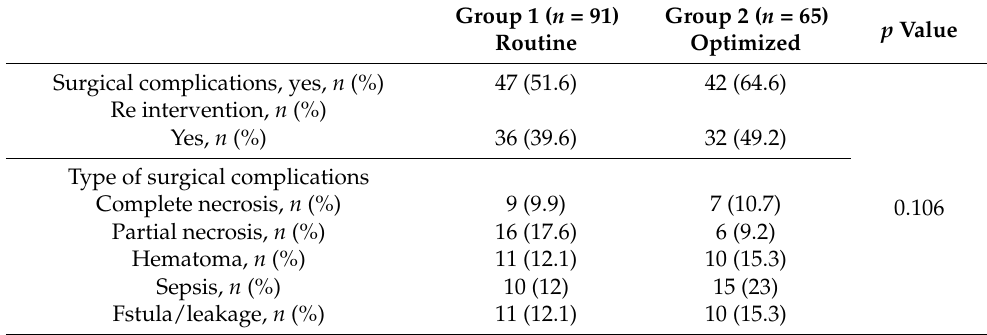
Table 6. Surgical